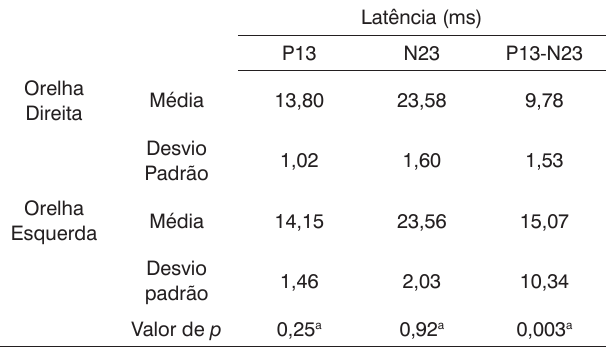
Tabela 1. Valores de latência do VEMP, do gênero feminino, por orelha.